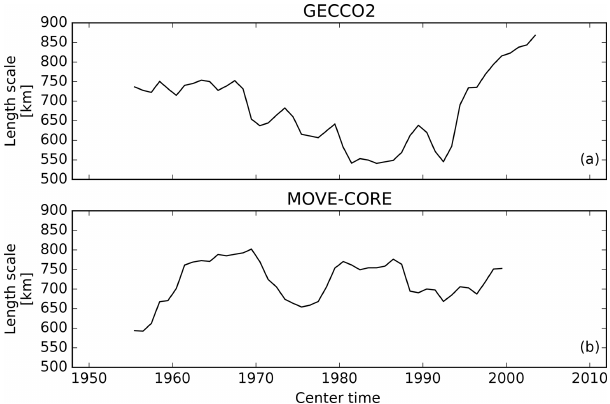
Figure 9. (a) Moving e -folding length scales estimated for the ice volume anomaly time series from the GECCO reanalysis. The win- dow length is 15 years, and it is stepped forward by 12 months over a total period of 64 years. (b) Same as (a) , but for the MOVE-CORE reanalysis, which has a time span of 60